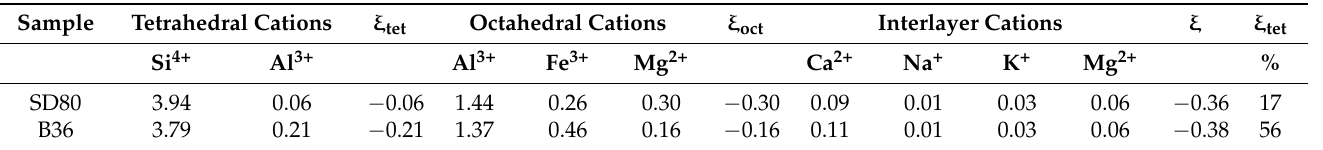
Table 4. Structural formula of purified smectites (<1 µ m) based on elemental composition determined by EDX (values are rounded and given in e · phuc − 1 ). Sample Tetrahedral